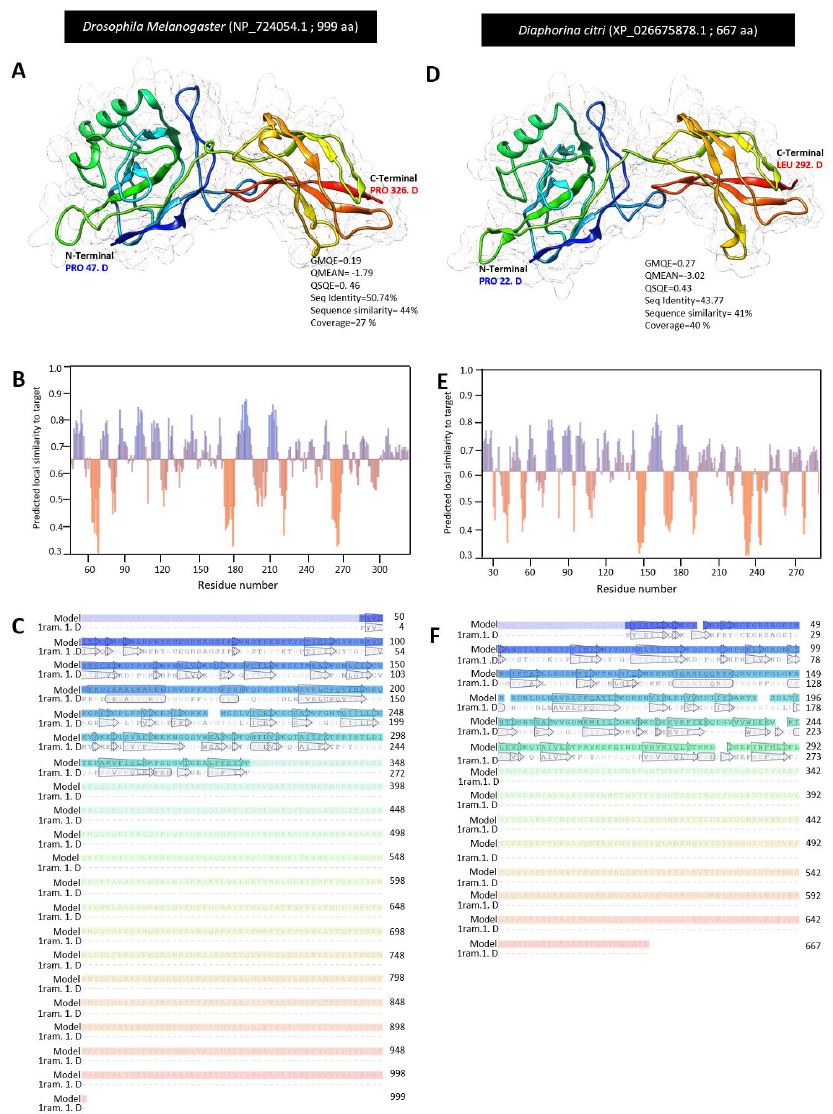
Figure 6. The crystallographic three-dimensional (3D) modeling of Dorsal protein of D. citri. ( A , D ) The predicted three-dimensional (3D) structure model and its associated mesh surface of DmDorsal (NP_724054.1) and DcDorsal (XP_026675878.1), respectively. The tertiary structures of Drosophila melanogaster and D. citri were predicted with the template of a 3D structure protein (tran- scription factor NF- κBp65) as a novel DNA recognition mode by NF- κB P65 homodimer in the Pro- tein Data Bank (PDP ID: 1ram.1.D with 2.70 Å resolution). Protein chains are colored according to the rainbow color spectrum from blue (N-terminal) to red (C-terminal). ( B , E ) Model – template align- ment of DmDorsal and DcDorsal, respectively. Amino acid sequences of each model were aligned with template 1ram.1.D. The secondary structures of each model are presented by α -helices (rectan- gles) and β -pleated sheets (arrows). Matched sequences in alignment are presented in black. ( C , F ) Local quality estimate of the predicted models of DmDorsal and DcDorsal, respectively. All bioin- formatic analyzes were accomplished based on the most recent data available in GenBank, the